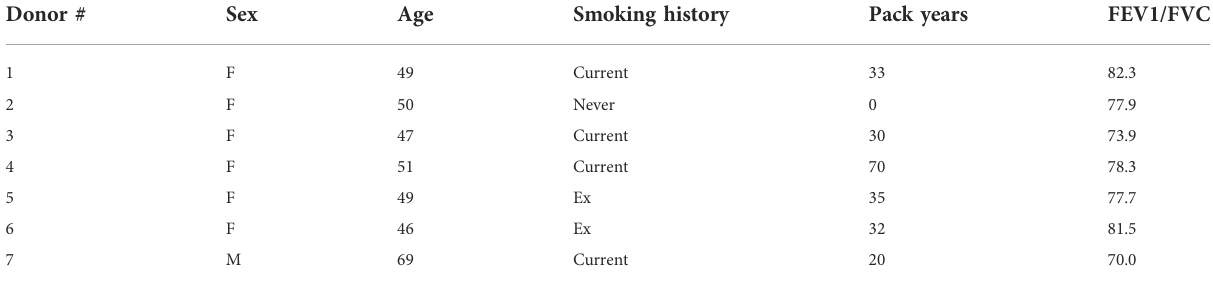
TABLE 1 Characteristics of fi broblast